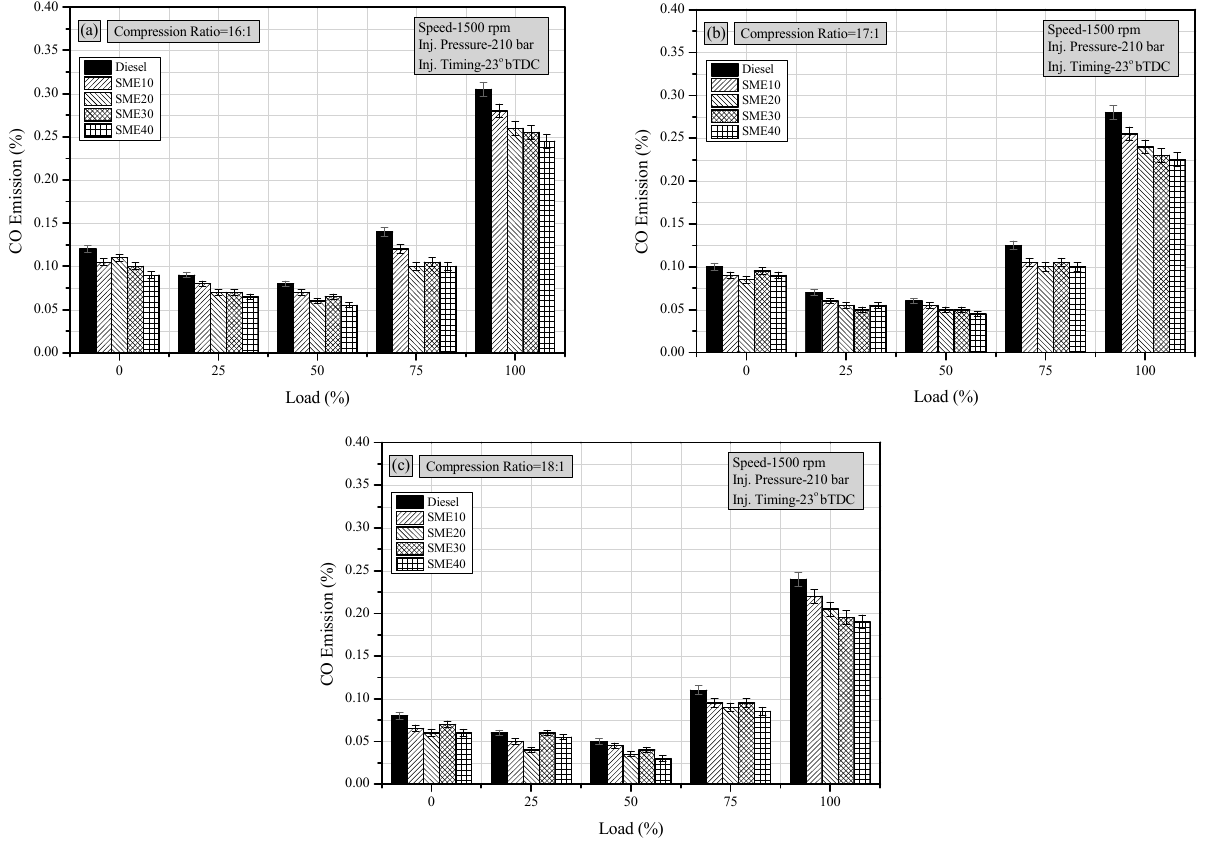
Figure 7. Variation of CO with load for the fuel blends at CRs: ( a ) 16:1 ( b ) 17:1 ( c )